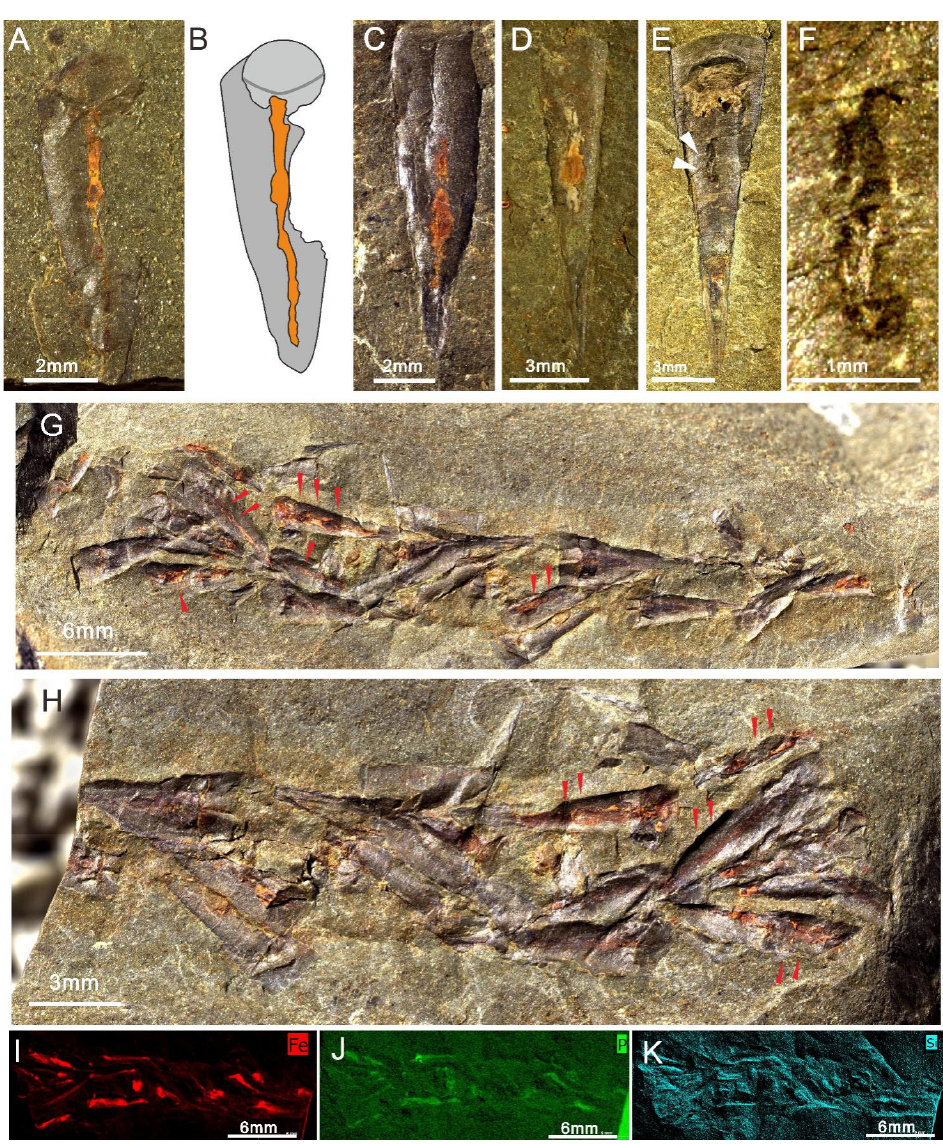
Figure 5. Doliutheca orientalis with soft-part preservation from the Shipai Formation of the Xiacha- zhuang section, Hubei Province, China. ( A , B ) One conch with articulated operculum with the di- gestive tract preserved as a red stain. ELI QJP-SP-H-379. ( B ) Interpretative sketch of ( A ), the diges- tive tract (orange) preserved in the conch (gray). ( C , D ) The gut of specimens preserved as a linear shape of reddish-brown color. ( C ) ELI QJP-SP-H-235. ( D ) ELI QJP-SP-H-343. ( E , F ) Hollow cavities composed of linear (marked by white arrows), dark-stained elements preserved in the conch center, ELI QJP-SP-H-029. ( F) Close-up image of hollow cavities in ( E ). ( G – K ) Part and counterpart of hy- olith concentrations, which preserved soft tissue in the disposition of the digestive system in the conchs (marked by red arrows). ELI QJP-SP-H-215a,b. ( I – K ) μ -XRF elemental mapping of iron, phosphorus and silicon, emphasizing the enrichment of iron.